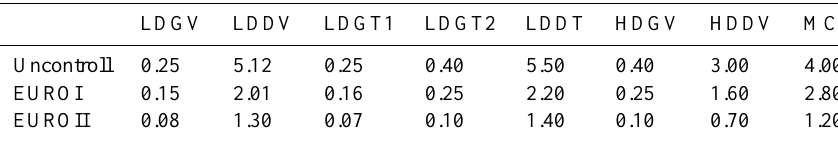
Table 3. PM EFs for on-road vehicles under different emission standards (gkg − 1